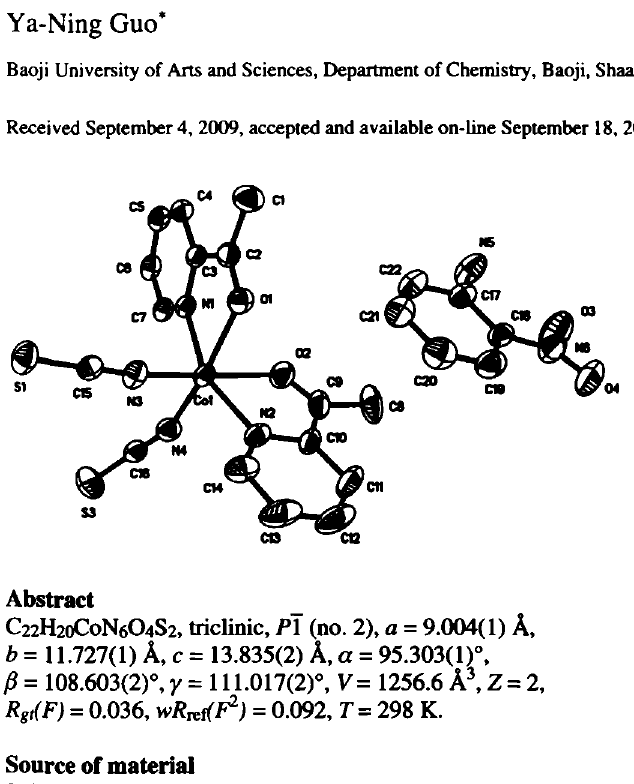
Table 1. Data collection and handling.